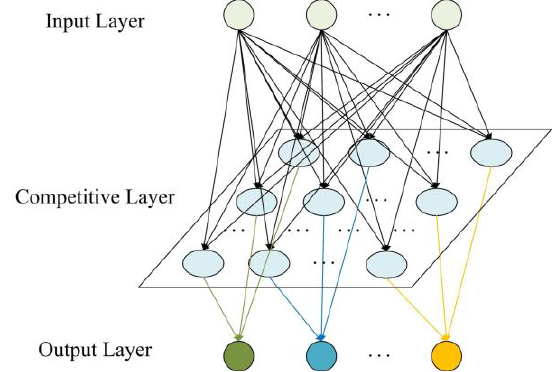
Figure 3. LVQ neural network.